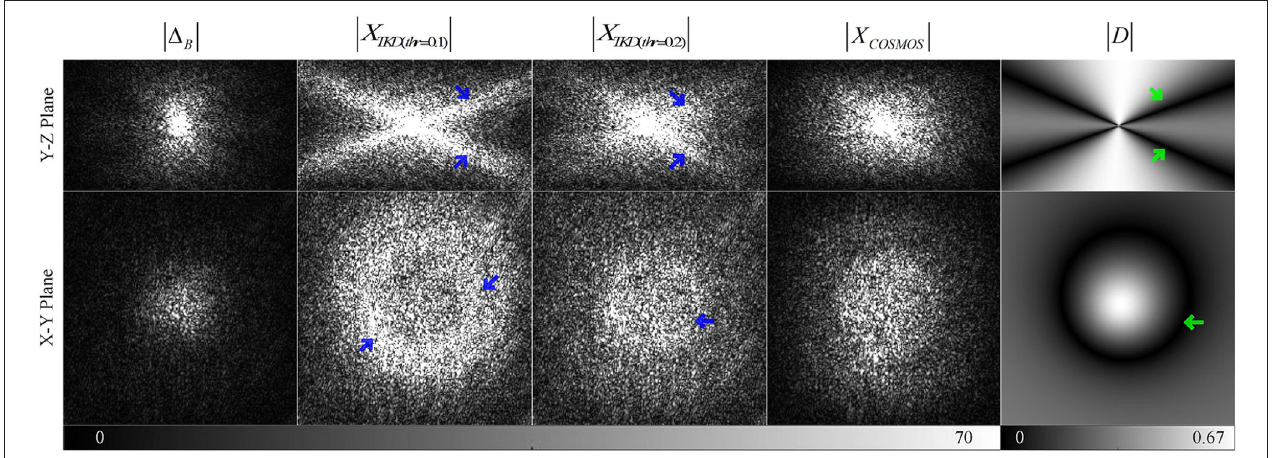
FIGURE 1 | Comparison of the k-space data of Field Map, TKD QSM, calculation of susceptibility through multiple orientation sampling (COSMOS) QSM, and dipole kernel in Y-Z and X-Y plane views (the X-Z plane is almost the same as the Y-Z plane) with green arrows indicating zeros in dipole kernel and blue arrows marking the ill-posed signals due to the